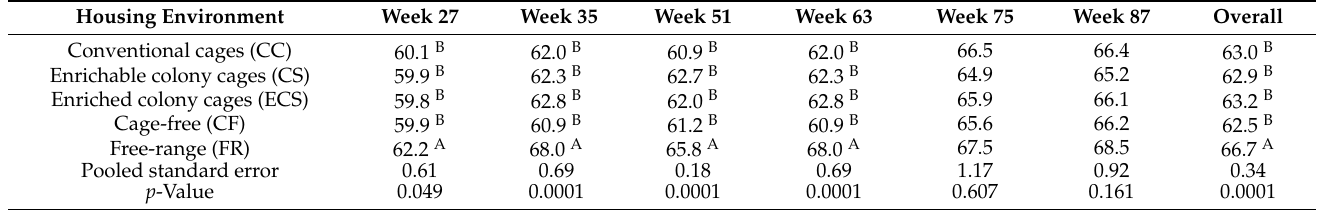
Table 4. The effect of housing environment on egg weight (grams) of brown egg layers by week and overall.